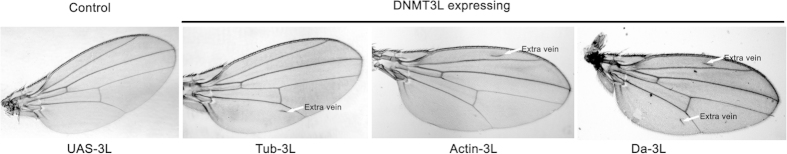
Ectopic DNMT3L expression causes wing phenotype in the transgenic Drosophila.Comparison of wings from control and transgenic DNMT3L flies showing extra veins in the DNMT3L expressing flies. Tub-3L, Actin-3L, da-3L - transgenic DNMT3L flies with Tubulin, Actin or daughterless GAL4 driver respectively. Extra veins in the wings are marked by arrows.